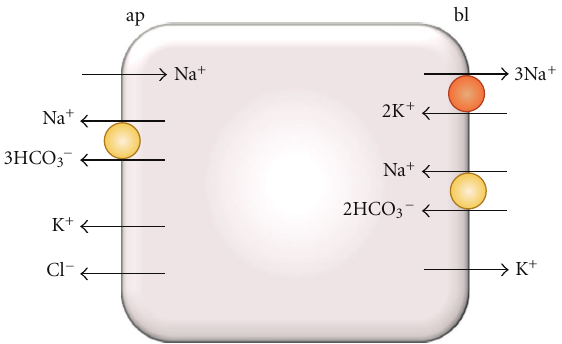
Figure 4: Scheme of a corneal endothelial cell showing electrogenic transport systems of the apical (ap) and basolateral (bl) membranes. Orange circle and arrows as in Figure 3, pale orange circles represent sodium-bicarbonate cotransporters; modified from Montalbetti and Fischbarg